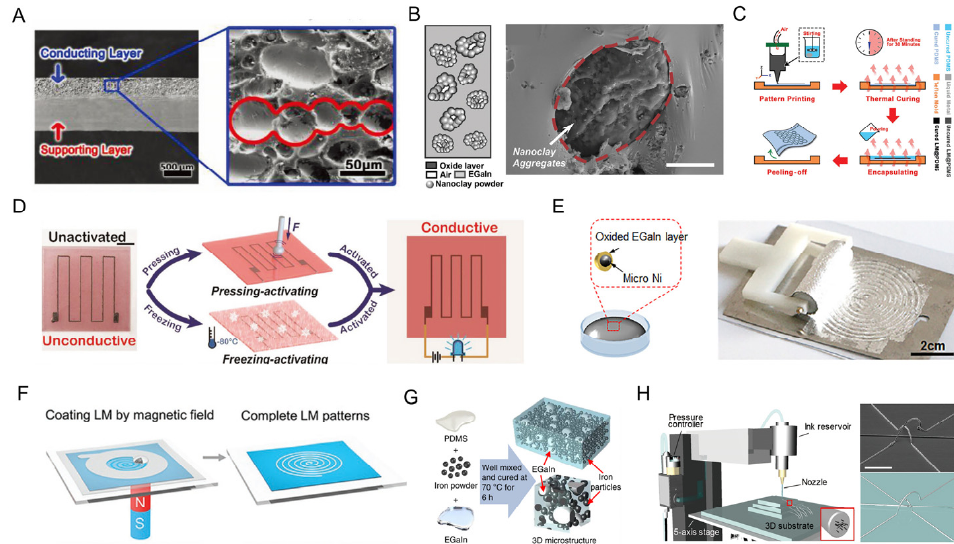
Figure 7. The surface tension reduction of LM via mixture. ( A ) Scanning electron microscope (SEM) cross-sectional view of the prepared LM-based composite elastic conductor with the desired 3D- Calabash Bunch conductive network structure in PDMS matrix [32]. Copyright: (2018) WILEY-VCH. ( B ) Schematic and the cross-sectional SEM of conductive nanoclay (scale bar: 20 mm) [79]. Copyright: (2021) The Royal Society of Chemistry. ( C ) Schematic depiction of the fabrication process for creating LM@PDMS stretchable, wearable electrically driven heaters [80]. Copyright: (2019) WILEY-VCH. ( D ) Activation of the printed electrical route through pressing and freezing [83]. Copyright: (2019) WILEY-VCH. ( E ) Schematic of Ni-GaIn amalgam, and the digital photograph for screen printing by a rolling brush [85]. Copyright: (2018) WILEY-VCH. ( F ) Schematic of high-resolution patterning of magnetic microparticle-doped LM via magnetic field control [86]. Copyright: (2019) WILEY- VCH. ( G ) Production of the liquid metal-filled magnetorheological elastomer [89]. Copyright: (2019) Springer Nature. ( H ) Schematic of the 3D direct printing system of CNT/LM composites (left), and the SEM images of 3D-printed CNT/LM composites [88]. Scale bars, 100 µ m. Copyright: (2019) American Chemical